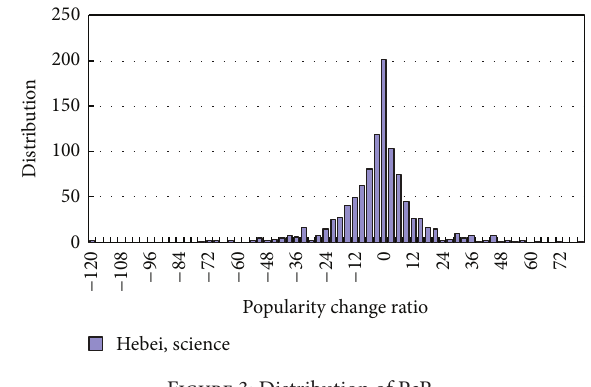
Figure 3: Distribution of